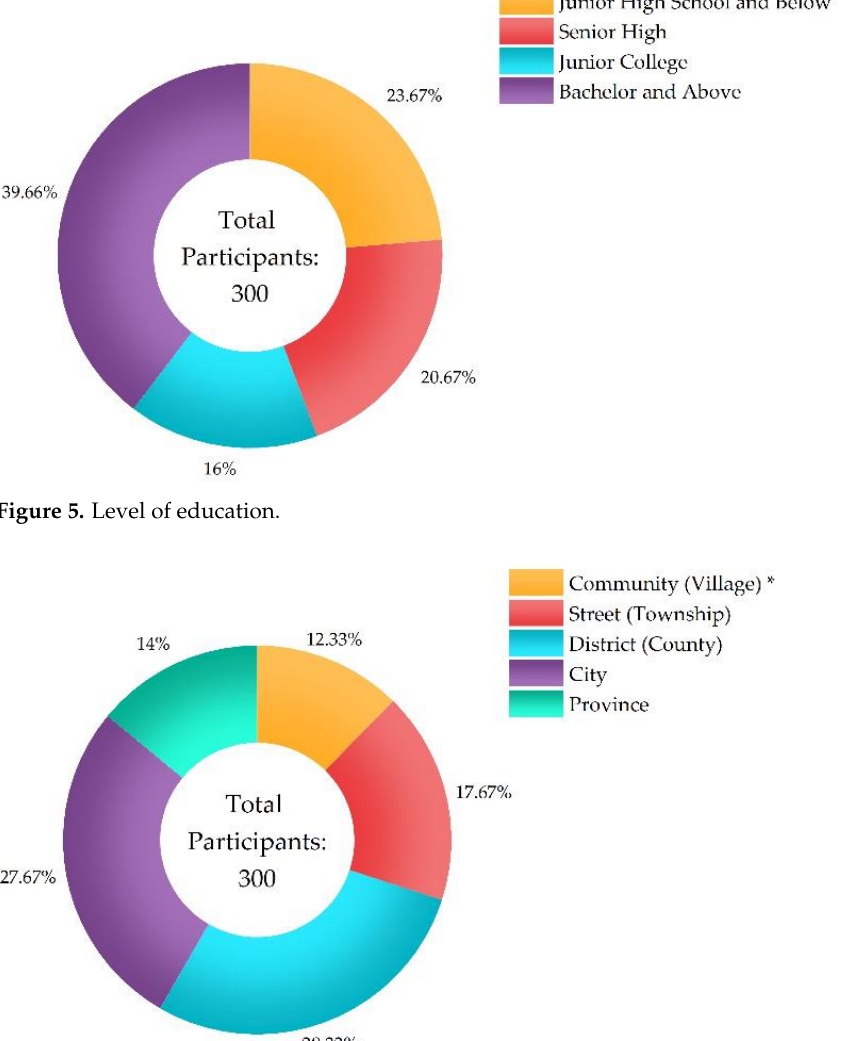
Figure 6. Distance between participants and infected individuals. * “Community (Village)” refers to residing in the same community or village as infected individuals, “Street (Township)” refers to residing in the same street or township as the infected individuals, “District (County)” refers to residing in the same district or county as the infected individuals, “City” refers to residing in the same city as the infected individuals, and “Province” refers to residing in the same province as the infected